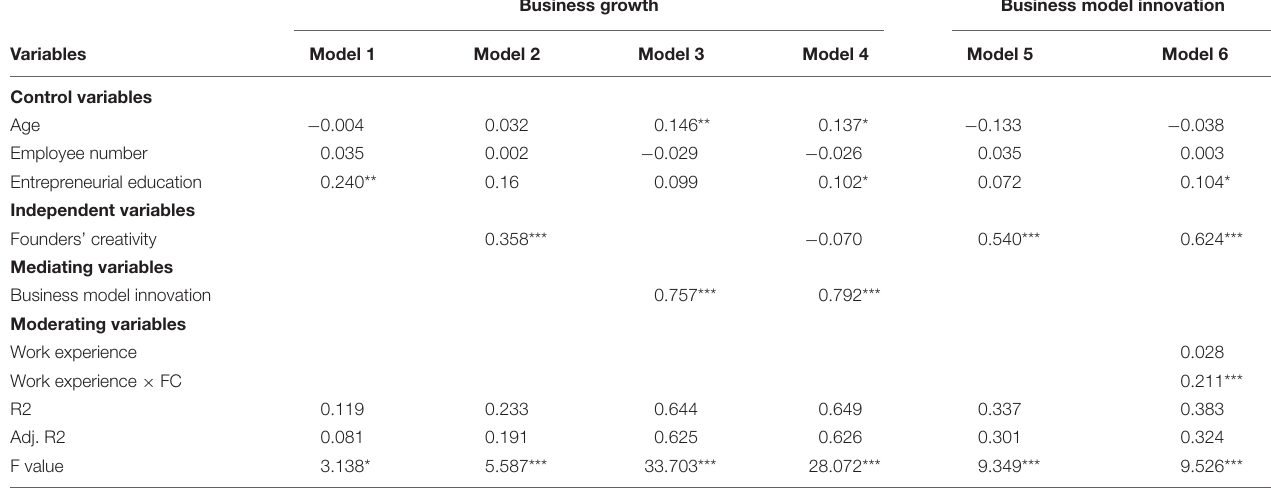
TABLE 4 | The results of regression